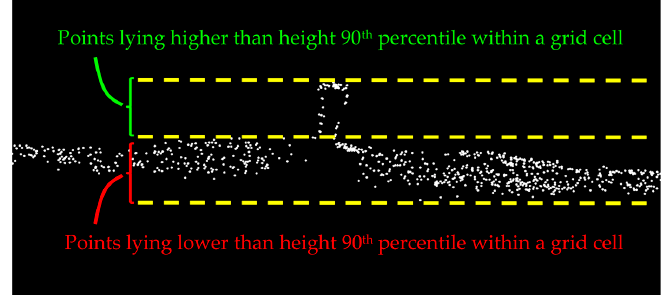
Figure 4 . The height 90th percentile threshold is utilized for the initial classification of points belonging to rail tracks within each grid cell.